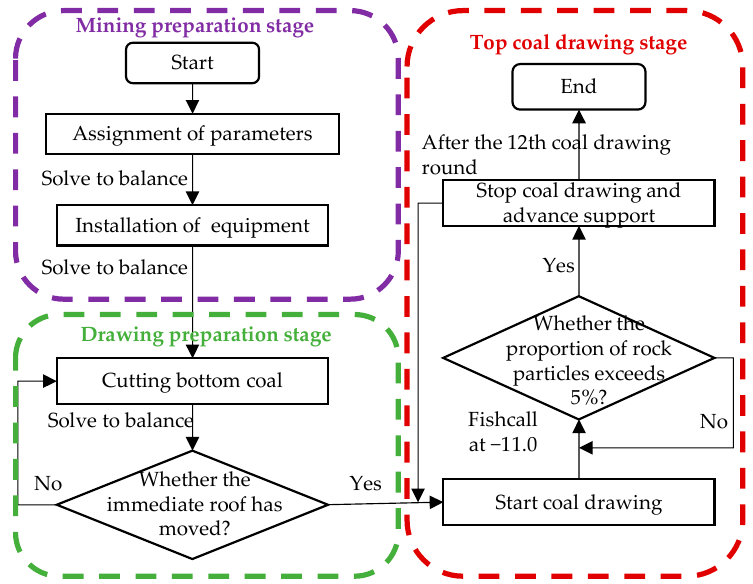
Figure 4. Flowchart for numerical simulation.